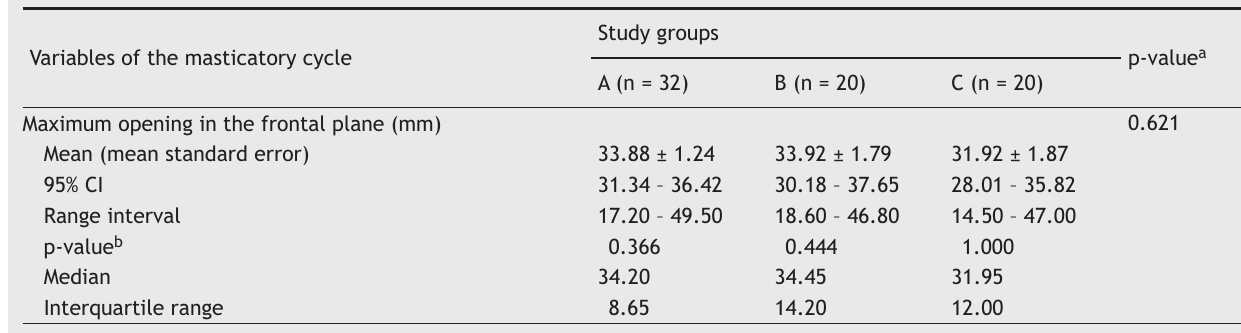
Table 1 Statistical parameters of the masticatory cycle